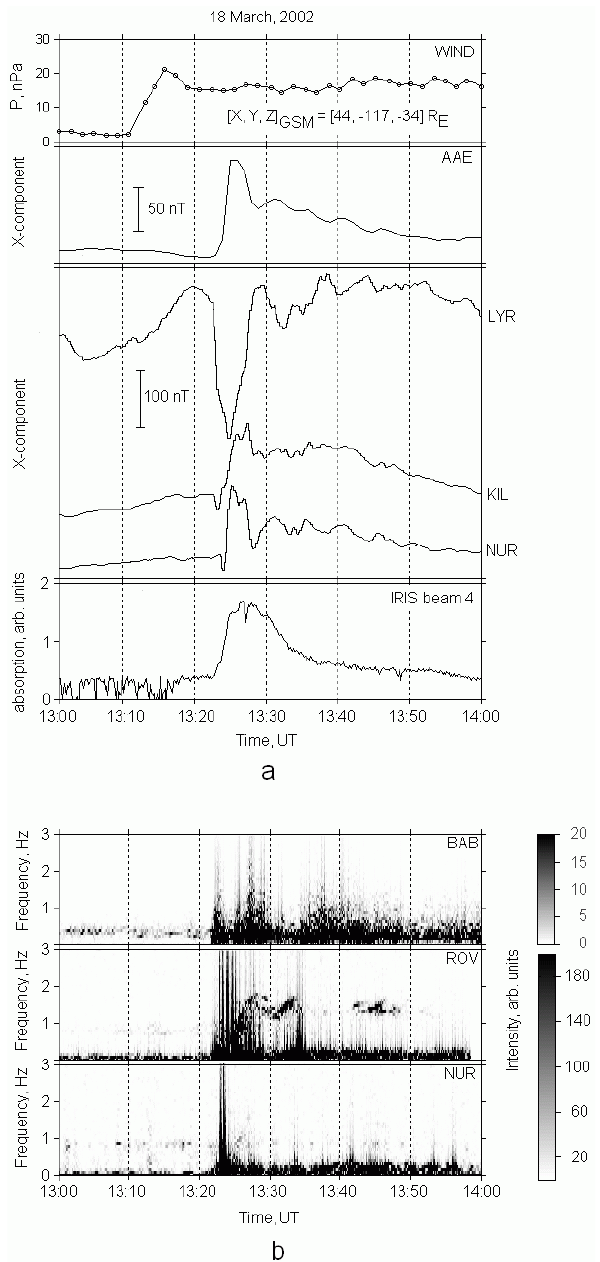
Fig. 2. (a) From top to bottom: solar win pressure pulse (SWPP) in space, magnetic response at equatorial station and in auroral zone, sudden absorption commencement (SCA); (b) sonograms showing the SWPP-initiated magnetic disturbances on the meridional chain of induction magnetometers.